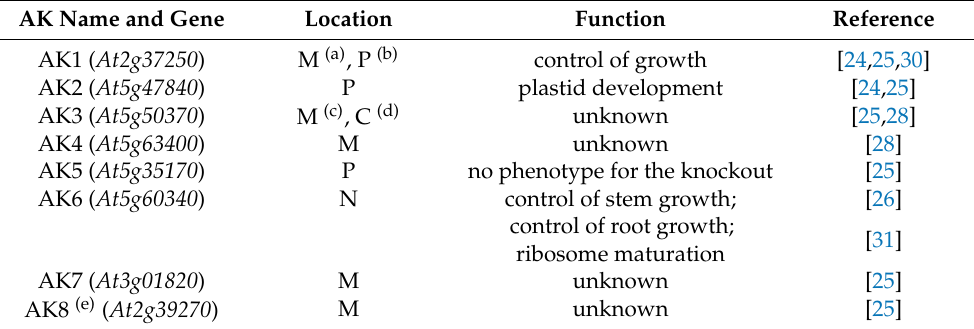
Table 1. Subcellular location and roles of Arabidopsis adenylate kinases (AKs). Classification of AK1-8 generally follows that of Lange et al. [25], with the exception of nuclear isozyme AK6, which replaced what is presented here as AK8. Mitochondrial location most likely refers to the presence of AK in mitochondrial intermembrane space (IMS), but not the matrix. C, cytosol; M, mitochondria; N, nucleus; P,